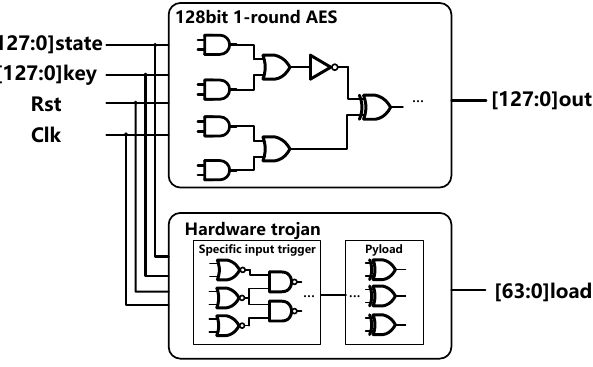
Figure 8. Design of inserted sneaky paths in benchmark